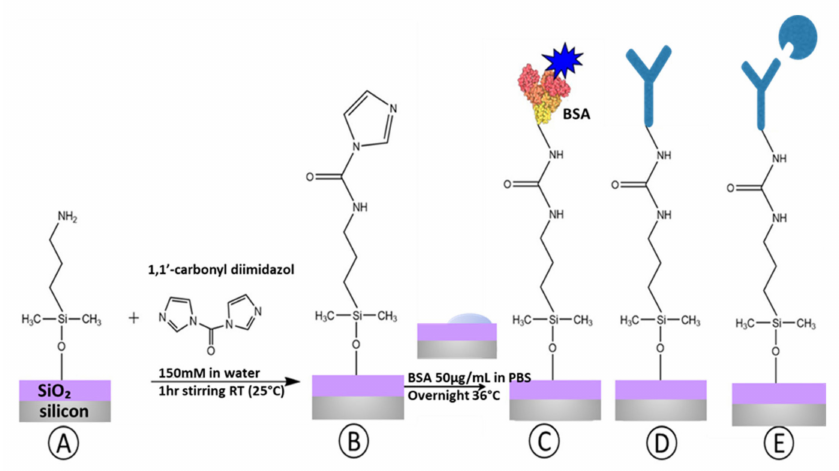
Figure 2. ( A ) Silanized surface, ( B ) NH 2 activation through CDI coupling, ( C ) BSA biofunctionaliza- tion, ( D ) Anti-MMP9 biofunctionalization, ( E ) MMP9